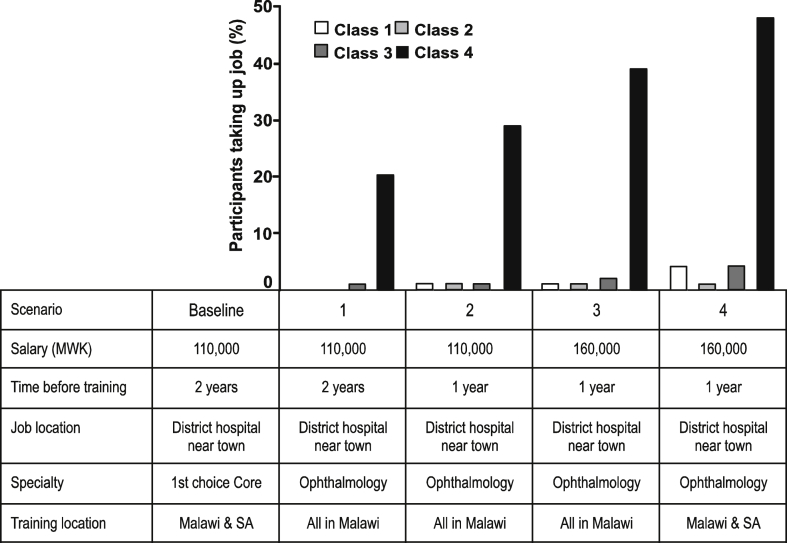
Improving uptake of priority specialties. The baseline scenario represents a common training pathway in Malawi. Scenario 1 represents the type of training post in ophthalmology that had been reportedly difficult to fill. Scenarios 2 to 4 offer increasing incentives to take up such a training post. MWK = Malawian kwacha; SA = South Africa.